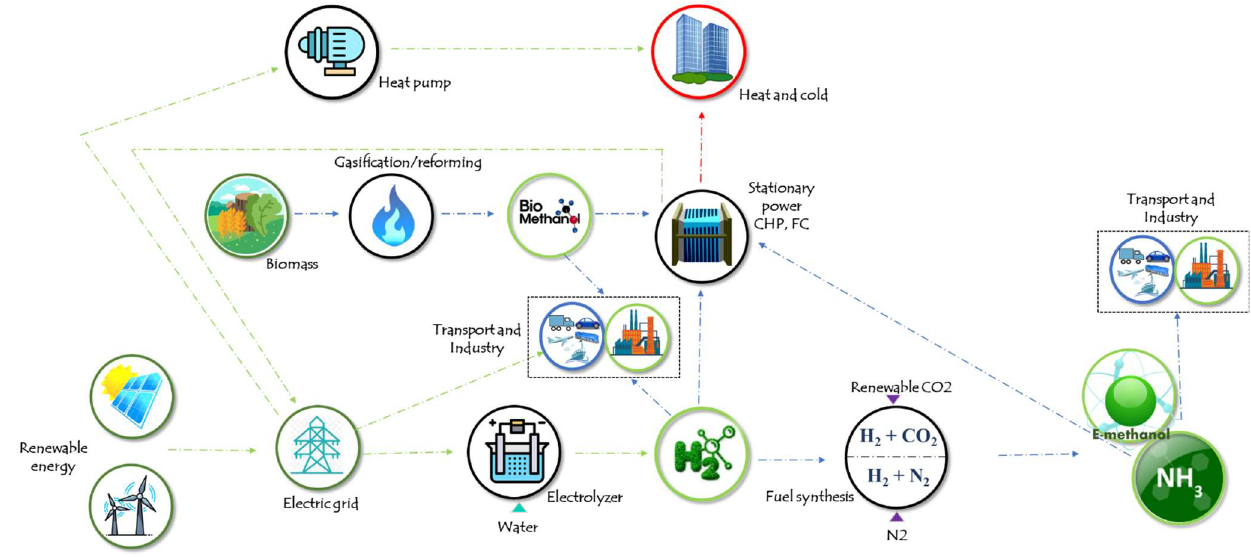
Figure 10. General production pathways of various carbon-neutral fuels and their key sector of ap- plication.